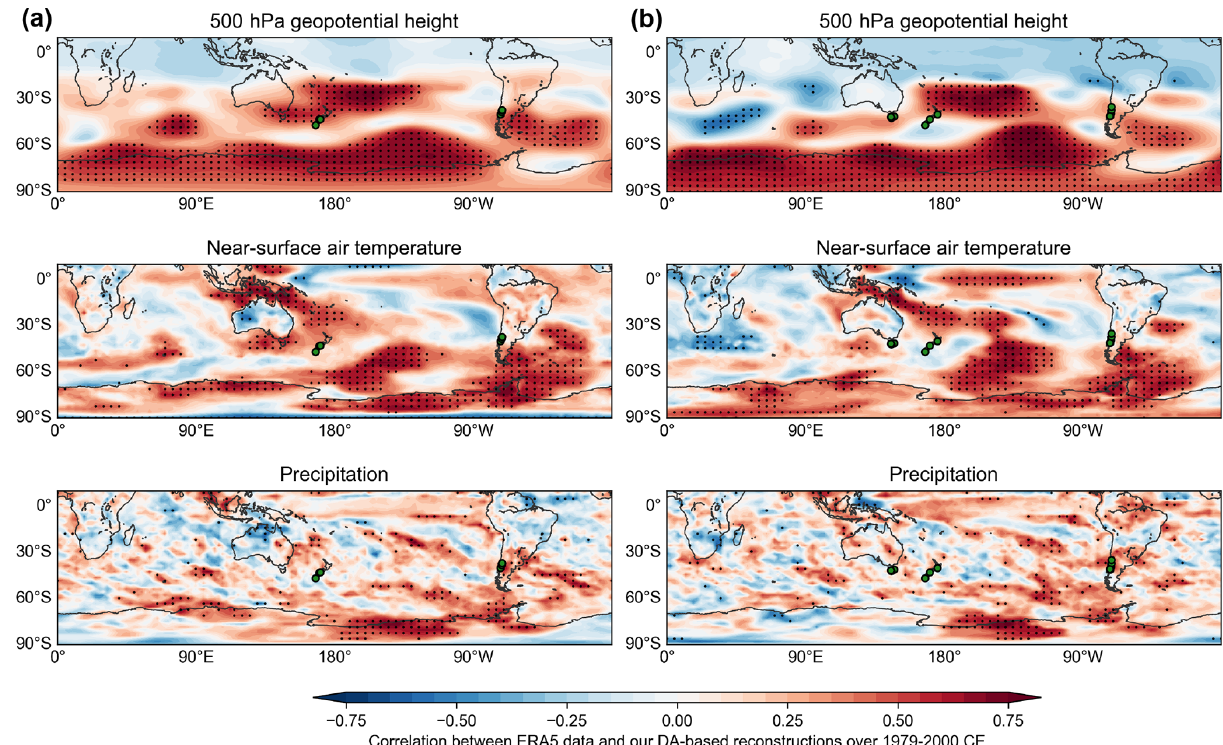
Figure 2. Pearson correlation coefficient between the reconstructed and ERA5 geopotential height at 500hPa, near-surface air temperature, and cumulative precipitation over 1979–2000CE for the TIC-MDN (a) and TIC-reg (b) experiments (see Sect. 3 and Table 1 for details on the experiments). The green dots indicate the localization of the assimilated tree-ring width records. The black dots indicate a significant correlation coefficient at the 95% confidence